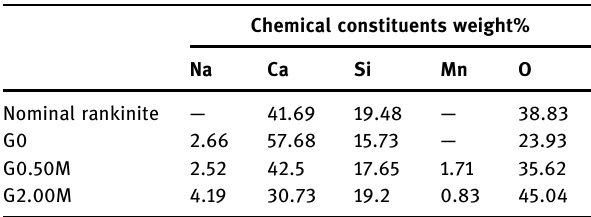
Table 2: EDX microanalysis of G0, G0.50M and G2.00M samples